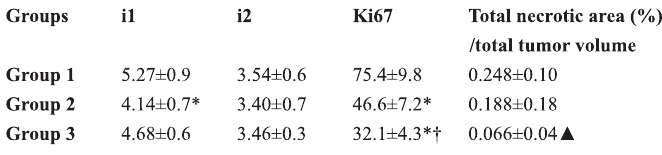
TABLE 1 - Number of intra-/ peri-tumoral vessels, glomeruloid microendothelial proliferations and total necrotic